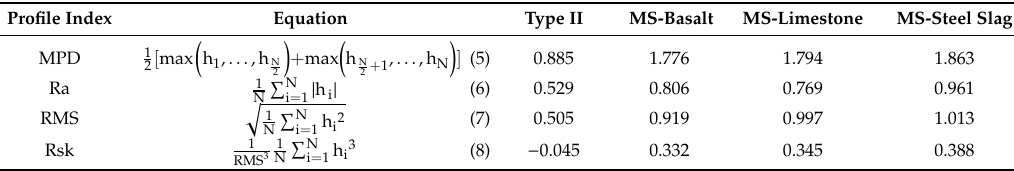
Table 5. Profile indicators of four kinds of MS.